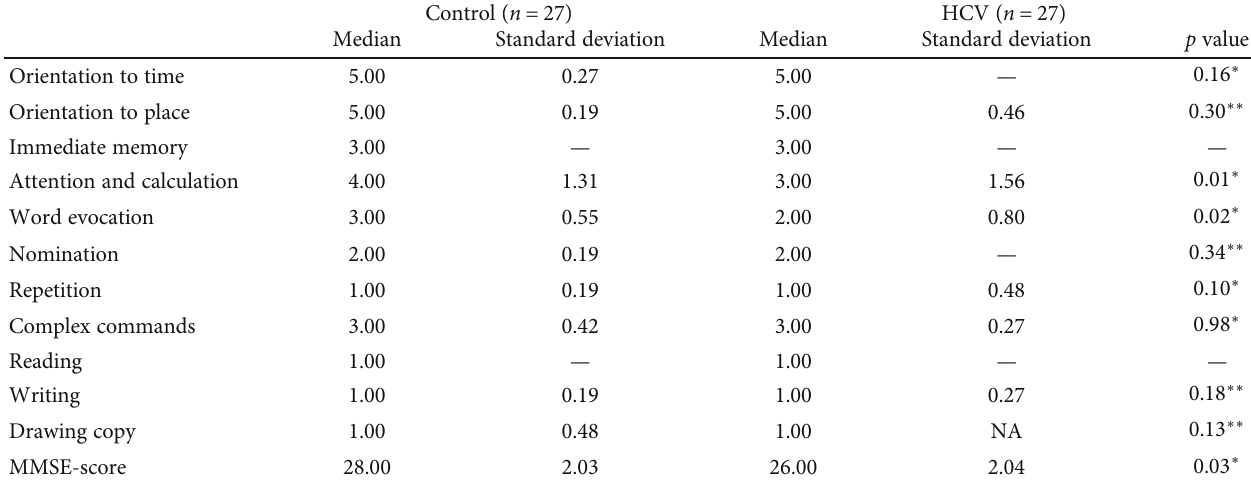
Table 4: Scores of patients with HCV infection and the control group on the items of the Mini-Mental State Examination.